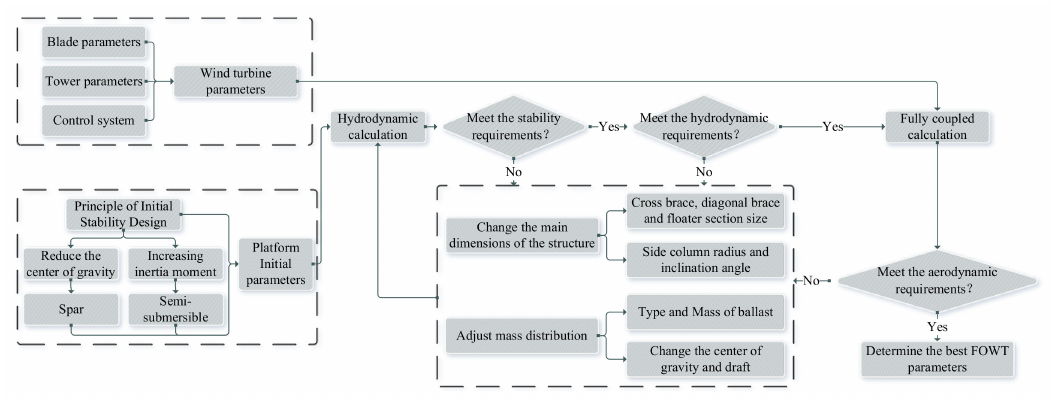
Figure 2. The flow chart of design optimization of offshore wind turbine floating platform proposed in this